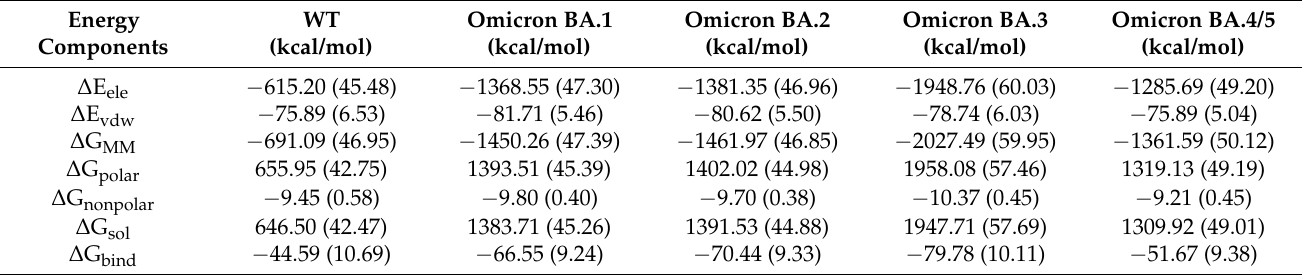
Table 1. BFE values calculated by MM-PBSA method a